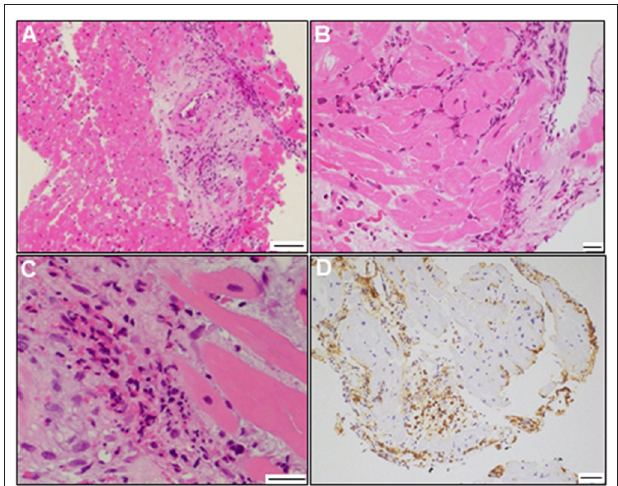
FIGURE 3 | Endomyocardial biopsy findings. Photomicrograph with hematoxylin and eosin staining (A–C) (bars: A, 100 µ m; B and C, 20 µ m). Photomicrograph showing immunostaining against the major basic protein (D) (bar: 50 µ